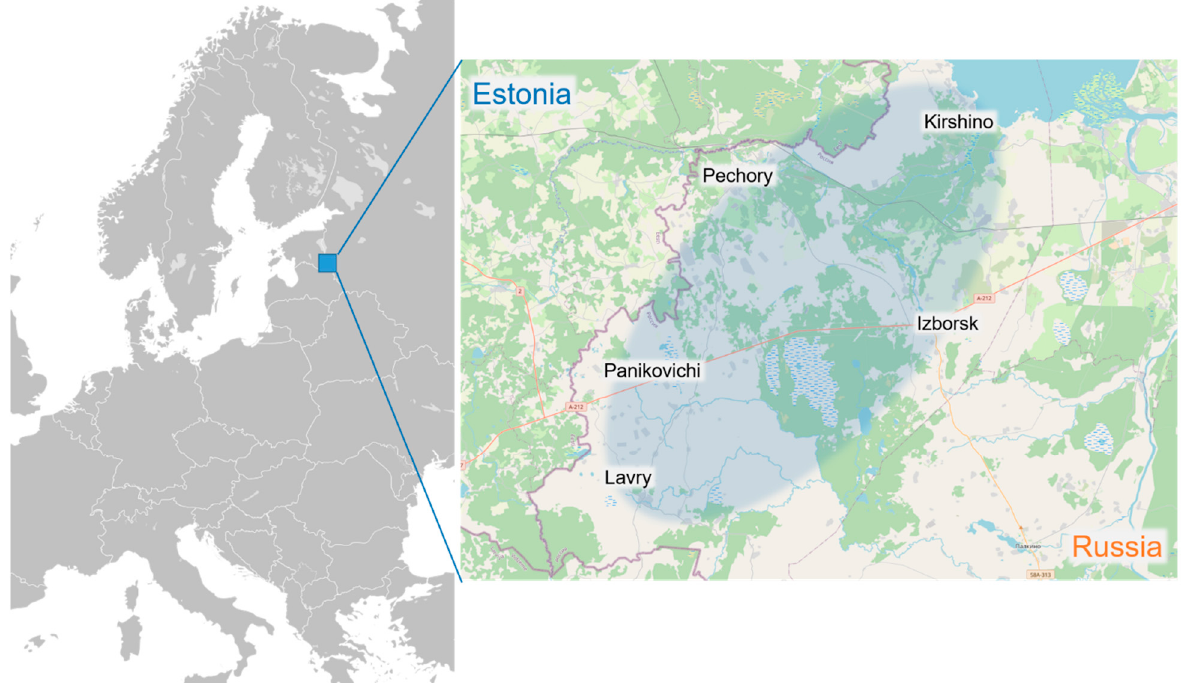
Figure 1. Study area in Pechorsky District of Pskov Oblast. Map base: Wikimedia Commons and OpenStreetMap.org. The youngest informant was born in 1980 and the oldest in 1916. Mean age was 68 for Russian participants and 60 for Seto participants. The interviews were conducted with 25 Setos and 31 Russians. We spoke to 38 female and 18 male participants (Table 2). Table 2. Demographic structure of the study